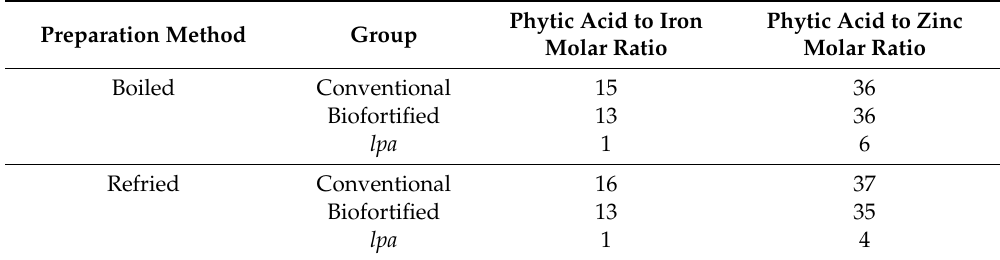
Table 8. Phytic acid to iron and zinc molar ratios for three groups of beans (conventional, biofortified and lpa ) and two preparation methods (boiled and